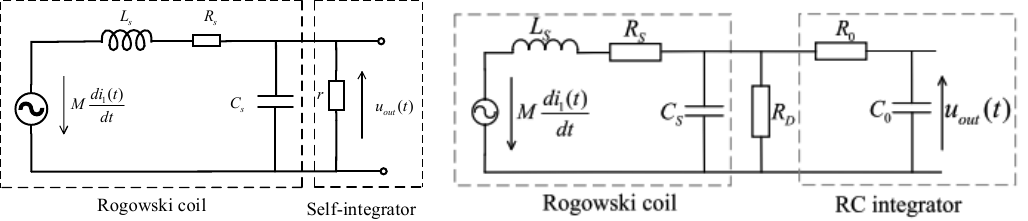
Figure 8. Self-integrator and external integrator.